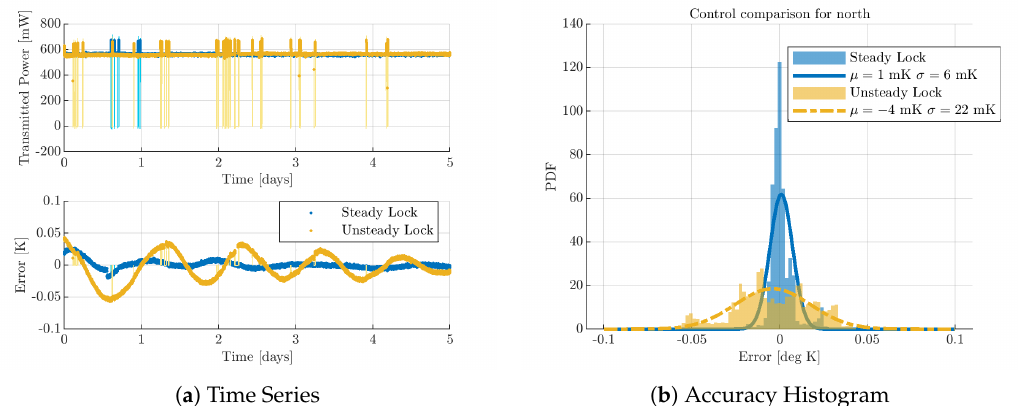
Figure 10. Comparison of the zero controller accuracy and precision for a period of steady lock and a period of multiple unlocks. The decreased precision during the unsteady period shows the need to develop a more sophisticated control for the unlock